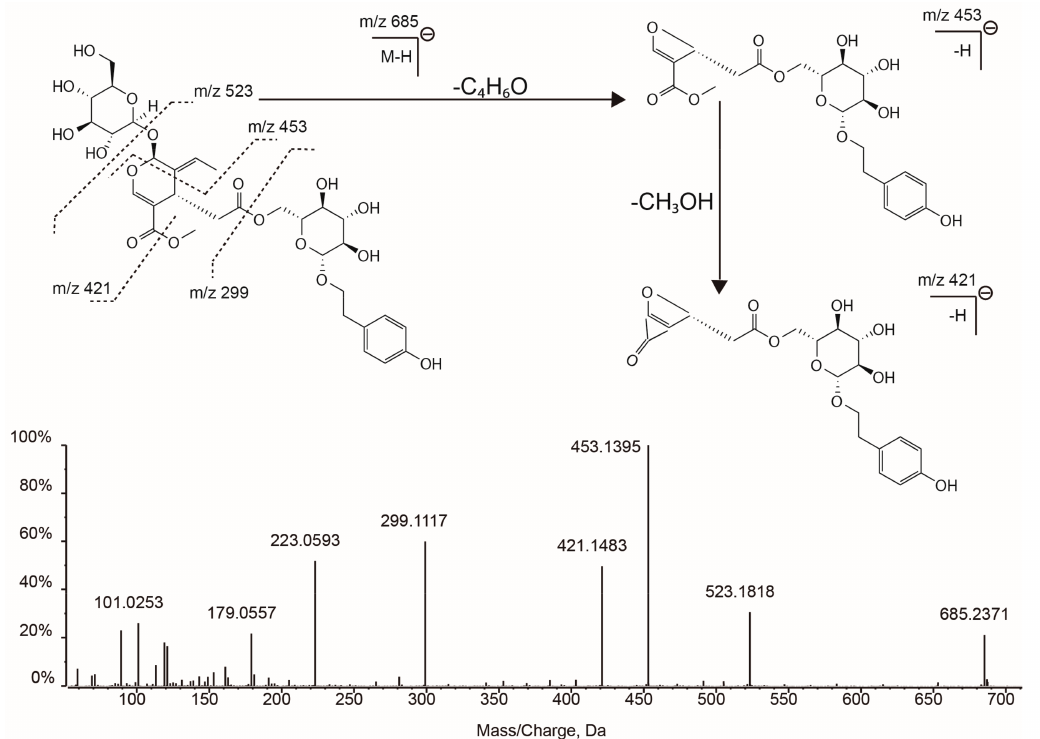
Figure 4. TOF-MS 2 spectrum and fragmentation scheme proposed for